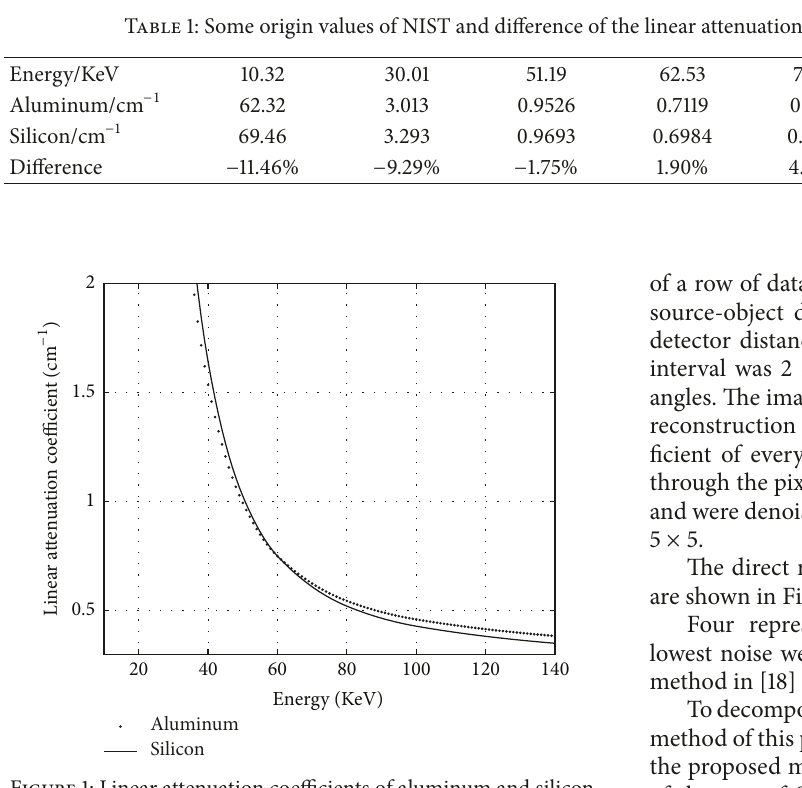
Figure 1: Linear attenuation coefficients of aluminum and